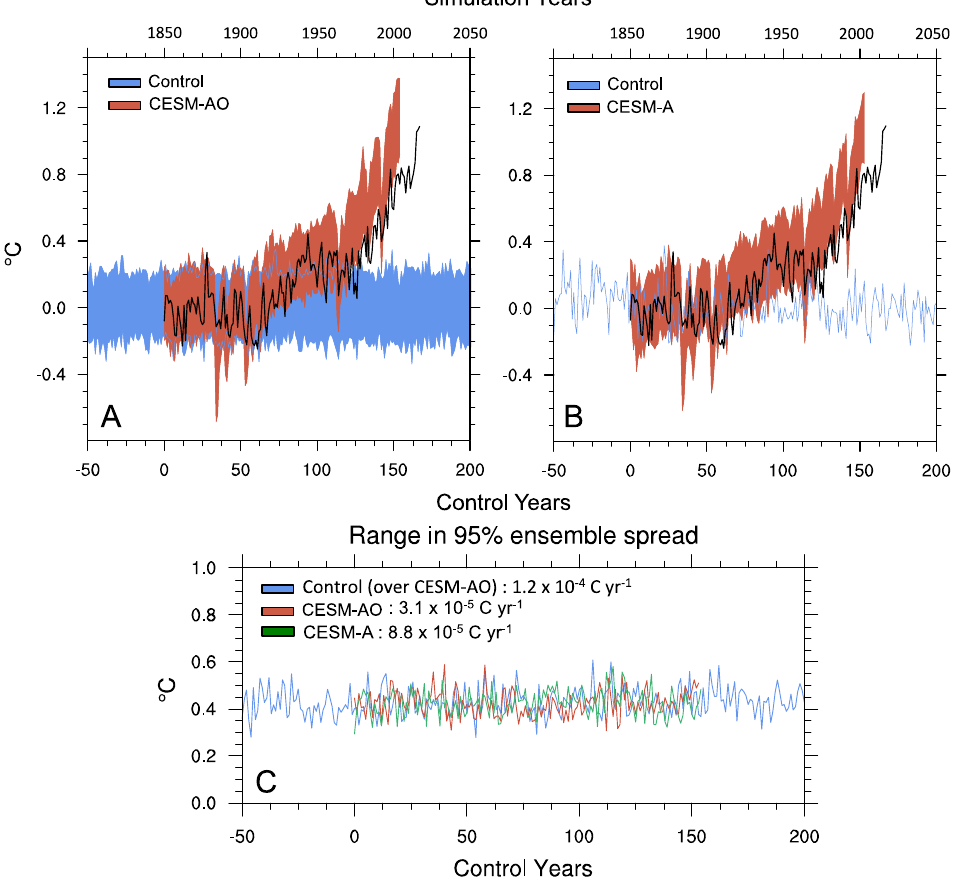
Figure 2. Globally averaged atmospheric surface temperature for CESM ‐ AO ( A ) and CESM ‐ A ( B ). See text for description of differences between ensembles. Blue lines ( A , B ) display timeseries of atmospheric temperature pre ‐ industrial control simulation. Red lines display historically forced simulations. The 95% range in ensemble spread is shown in ( A ) and ( B ). Black lines are observed globally average temperature from the HadCRUT4 dataset [48]. Timeseries of the 95% range are shown in ( C ). Values are the linear trend in ensemble spread over the period shown from 0–150 years.